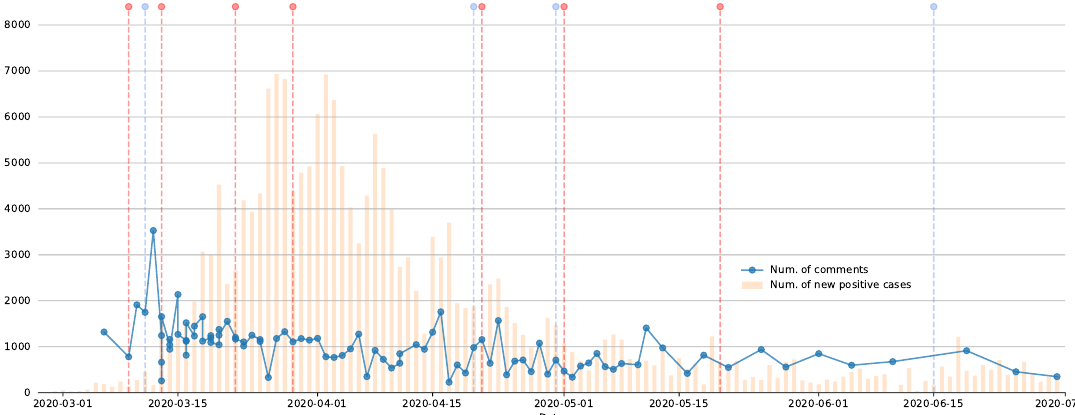
Figure 5. Number of comments per megathread in /r/italy compared to the number of new daily cases in Italy. Vertical lines represent adopted critical events and policies.